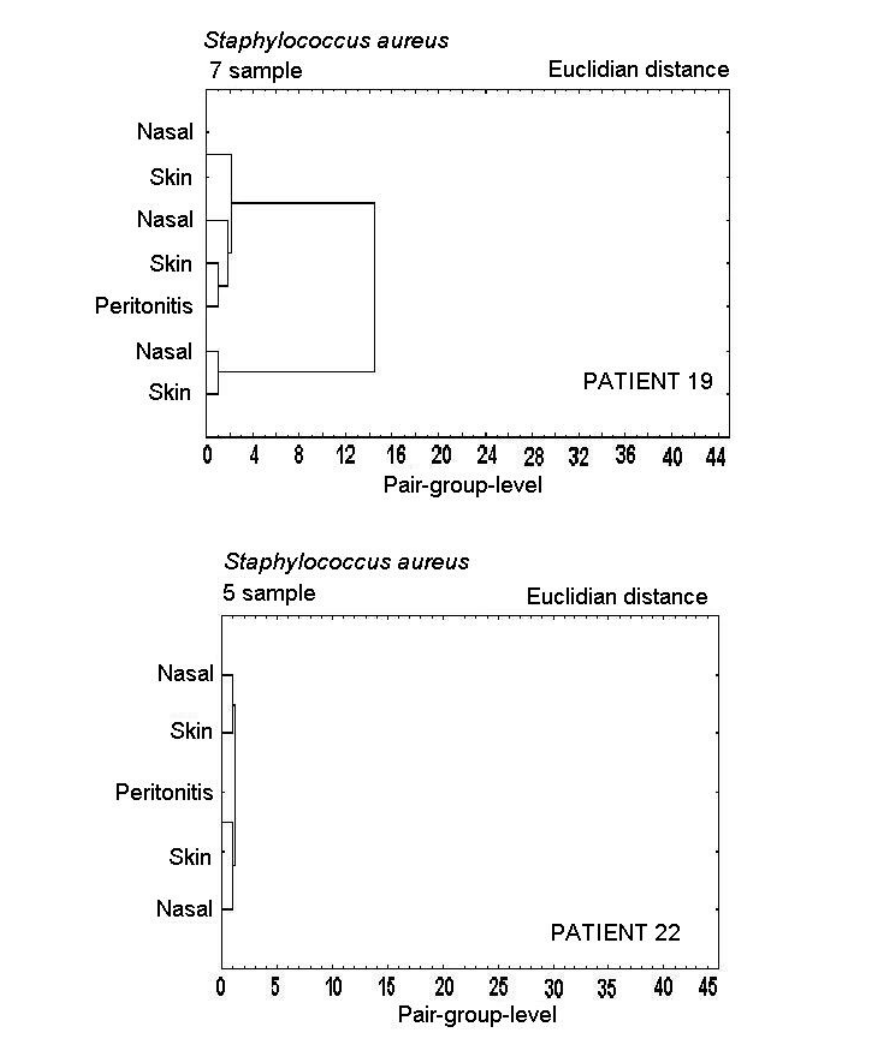
Figure 2: Similarity dendrograms drawn based on inhibition halos obtained by using the agar disk diffusion technique for S. aureus isolated from the nasal cavity, pericatheter skin and peritoneal effluent of two patients undergoing peritoneal